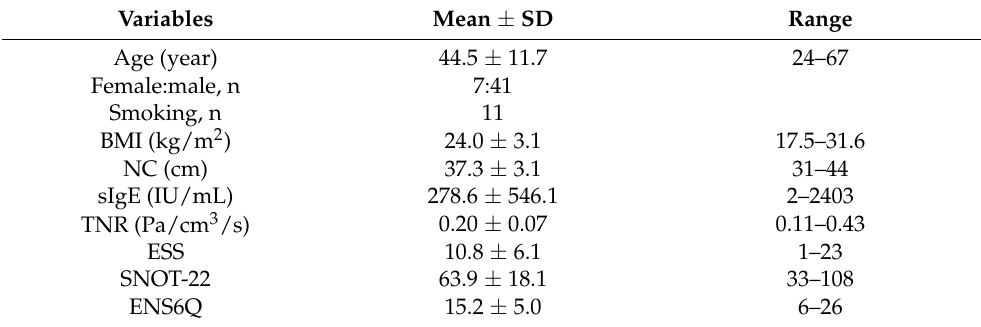
Table 1. Clinical characteristics of the study participants.